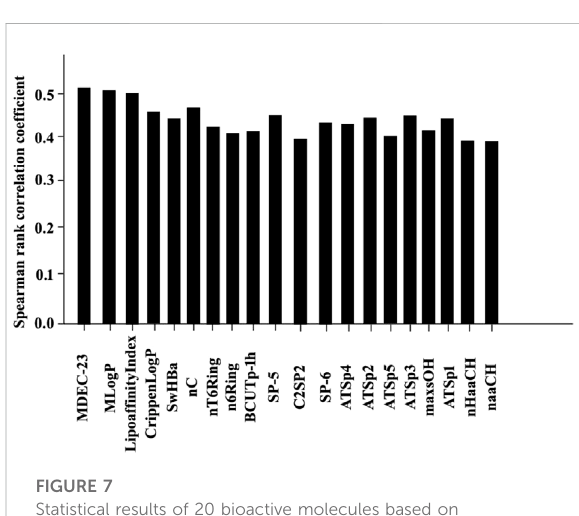
FIGURE 7 Statistical results of 20 bioactive molecules based on Spearman rank correlation coef fi cient